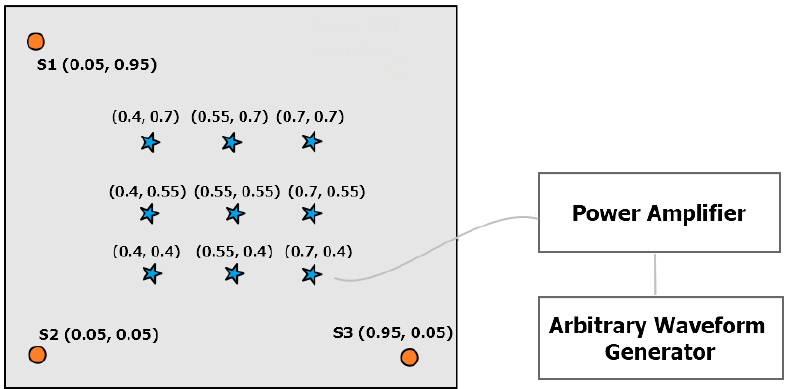
Figure 8. Sensor deployment diagram on the metallic laboratory plate used for the sake of source